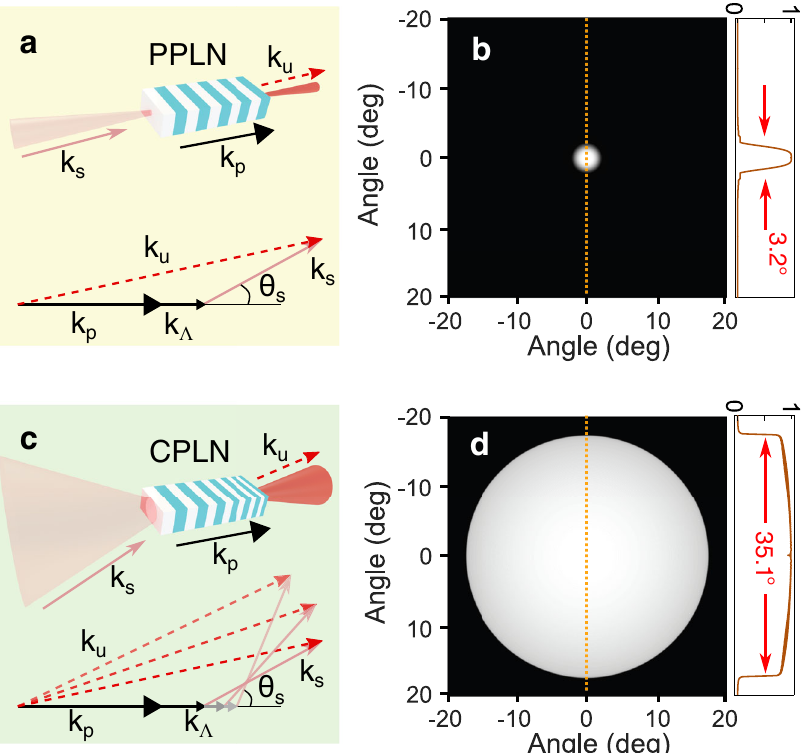
Fig. 1 Principle and performance for the wide- fi eld upconversion imaging. a Conventional scheme for the upconversion imaging with a periodical-poling crystal, where the intrinsic fi eld of view is severely limited by the phase-matching requirement. b presents the typical fi eld of view of several degrees. The section pro fi le corresponds to the dashed line in the image. c Proposed scheme to enlarge the fi eld of view based on a chirped-poling nonlinear crystal. The tolerance for the incident angle is signi fi cantly improved due to the appropriate grating periods within a large adaptation range. d shows the theoretical performance. The full angle of the vision cone can be extended to